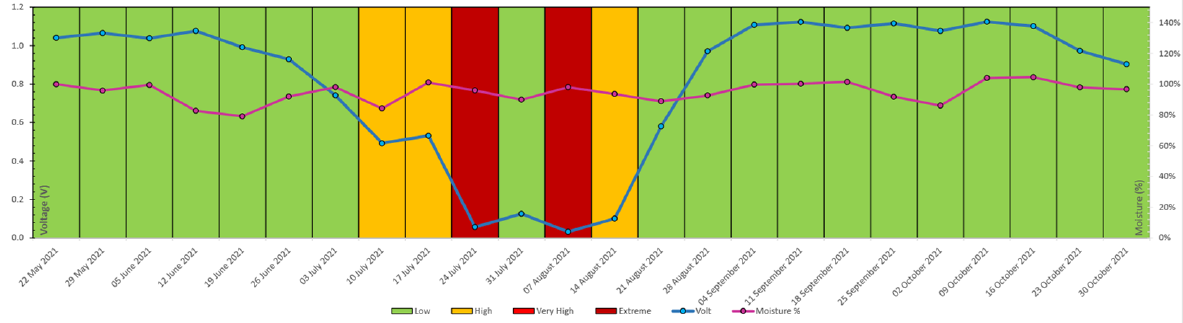
Figure 8. Mean values of V (blue line) and BBMC% (pink line) vs. FWI classification of the measure- ments according to FWI criteria during the 24 weeks study (background colour).